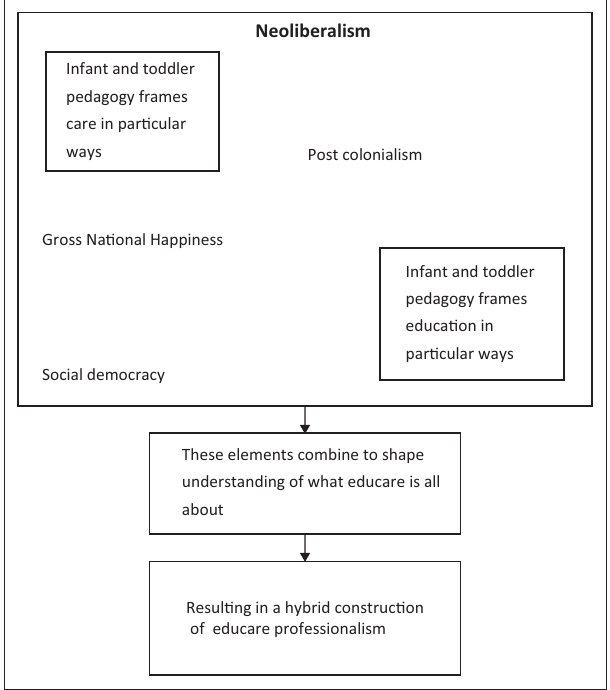
Figure 1: Illustration of the Conceptual